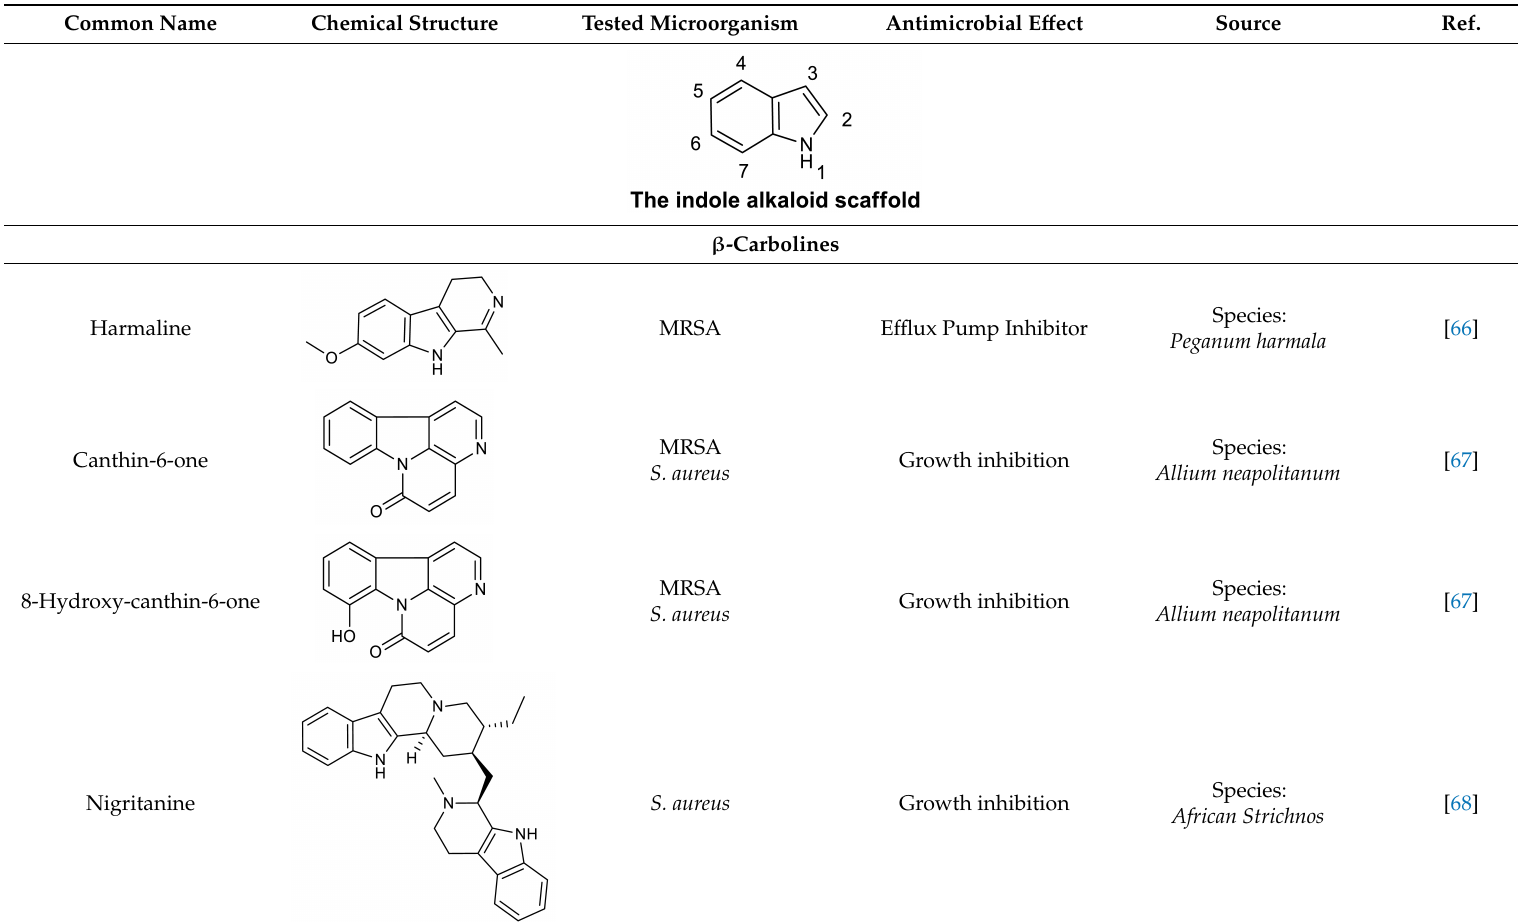
Table 3. Chemical structure and antimicrobial activity of some representative indole